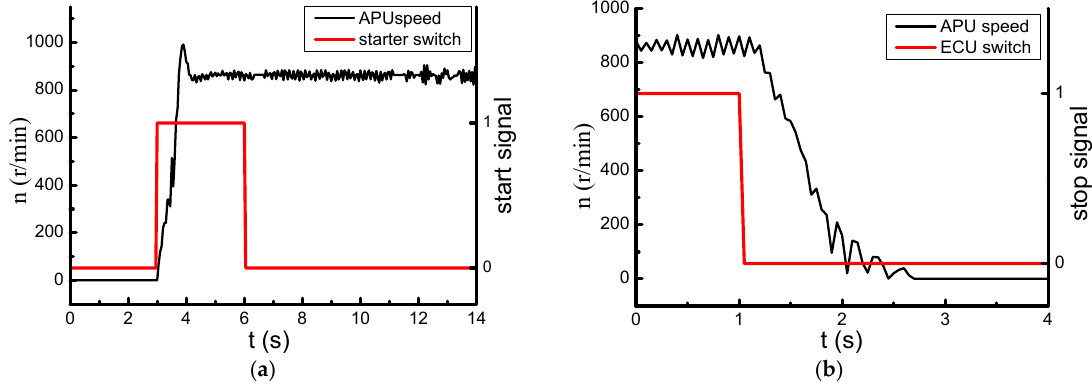
Figure 15. APU start-stop test results. ( a ) APU system start-up process; ( b ) APU system shut down process.